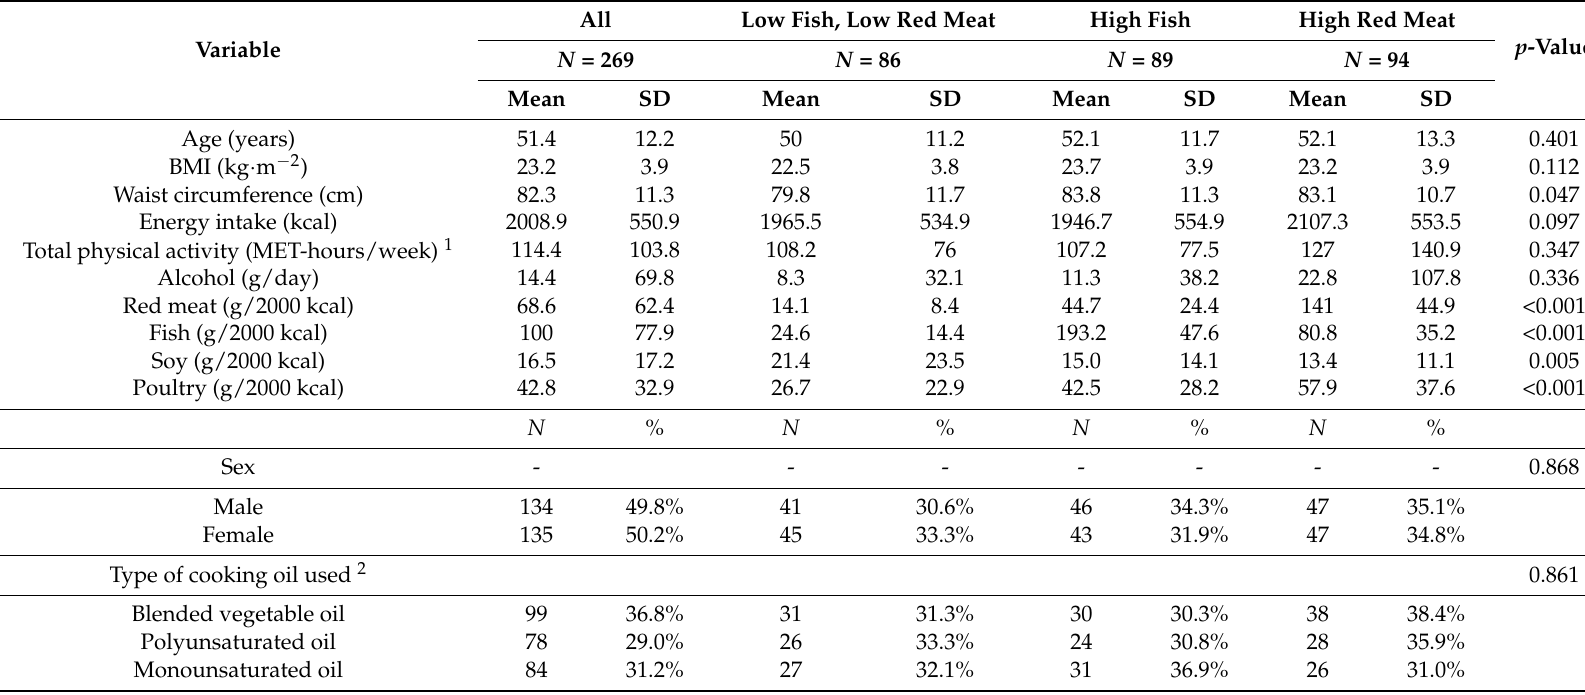
Table 1. Characteristics of 269 Singapore Prospective Study participants with high red meat, high fish, or low red meat and fish consumption.